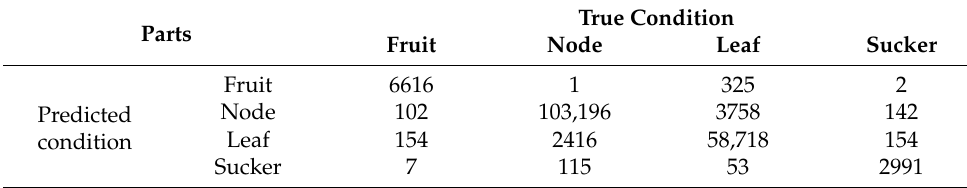
Table 7. Results of the BP